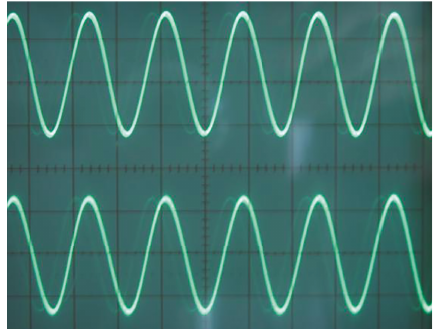
Figure 18: Transmitting and receiving signal photo.